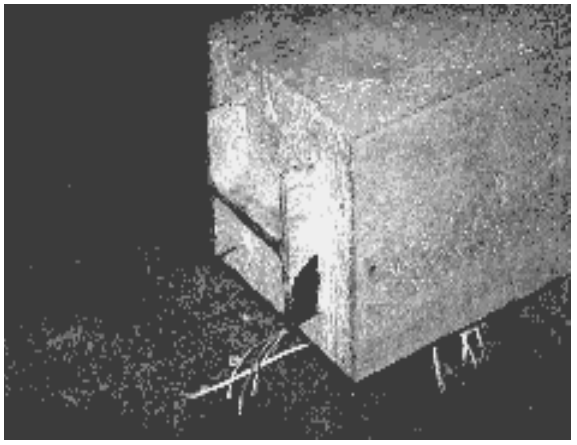
Fig 2 . The column head with a shape protruded from a column section